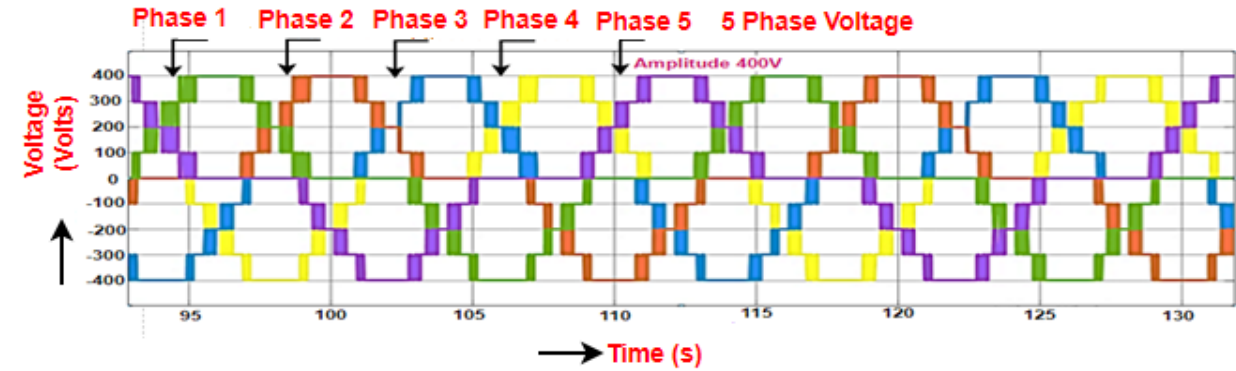
Figure 14. Output voltage of NPC—MLI.